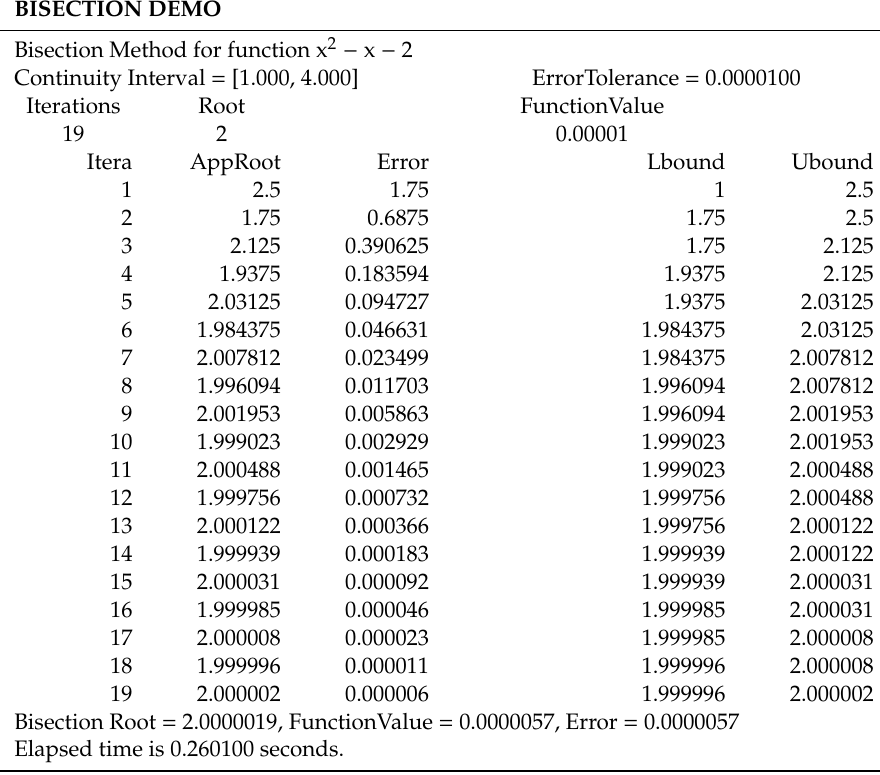
Table 4. Bisection algorithm, iterations, AppRoot, error and interval